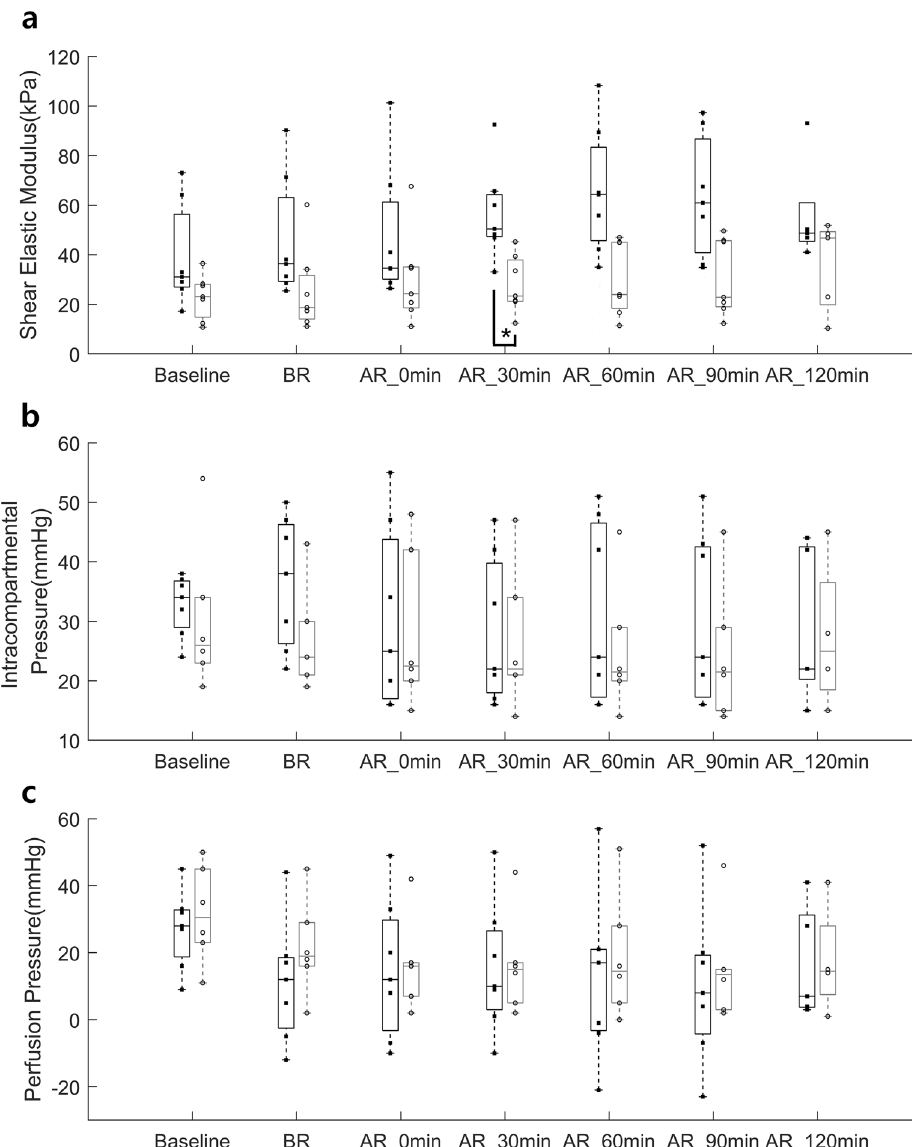
Figure 5. (a) Shear elastic modulus, (b) intracompartmental pressure, and (c) perfusion pressure between the experimental leg (black barplot) and the control leg (gray barplot) at each time point (baseline, BR, AR_0 min, AR_30 min, AR_60 min, AR_90 min, and AR_120 min). Each dot indicates each data point in each group. Each bar plot indicates 25th (Q1), 50th (Q2), and 75th (Q3) percentiles of the data. The whisker indicates Q3 + 1.5 × (Q3–Q1), and Q1 − 1.5 ×